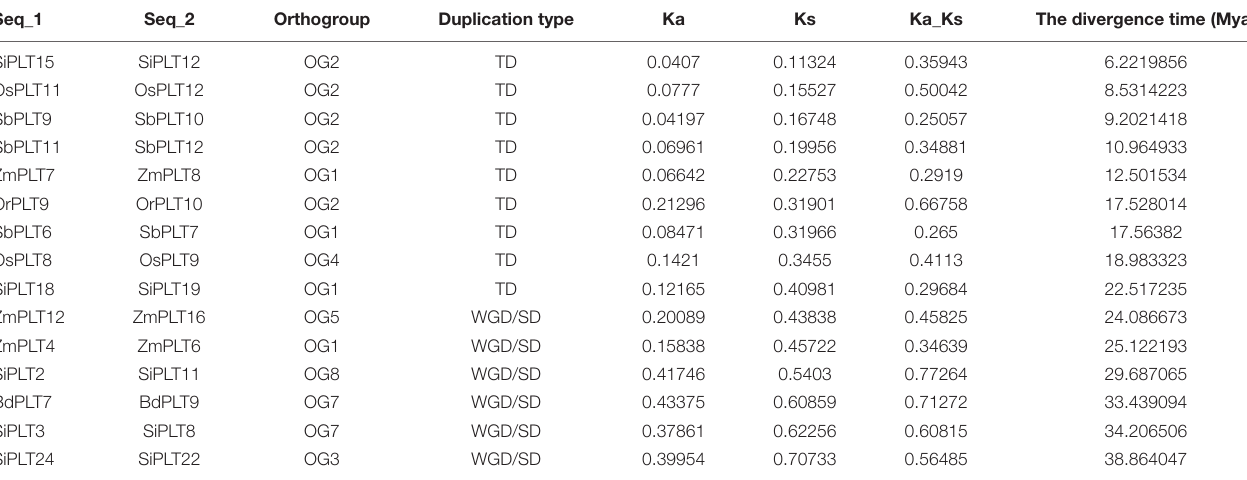
TABLE 1 | Ka/Ks values and the divergence times of duplicate gene pairs in seven tested species.